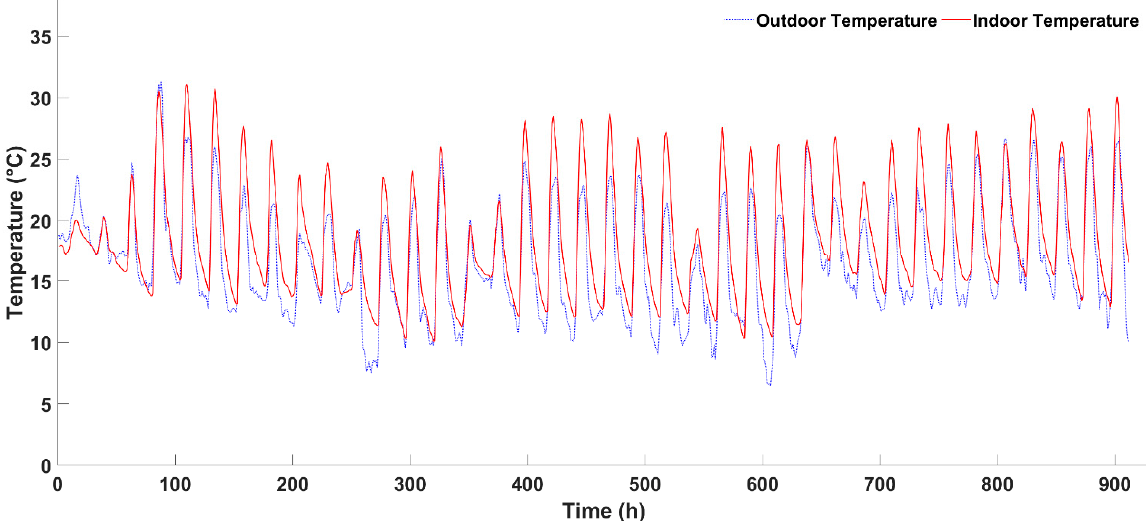
Figure 20. Experimental temperature evolution inside the building in response to weather conditions.